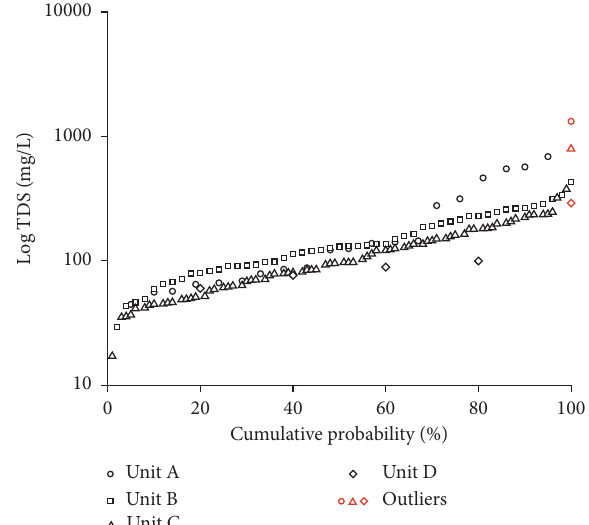
Figure 3: Outliers in PS datasets in various groundwater units tested by Grubbs’ test.